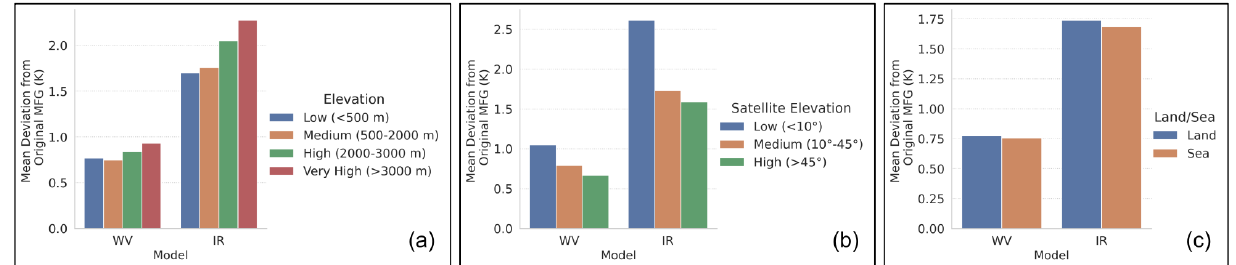
Figure 13. Performance of WV and IR models in different sub-regions classified according to: ( a ) Elevation, ( b ) Satellite Elevation (varies from 0 ◦ at the disk edges where satellite barely rises above the horizon to 90 ◦ at nadir), and ( c ) Land–Sea. The y-axis represents the mean deviation in synthesized MFG WV and IR channel BT values (K) from the original values.